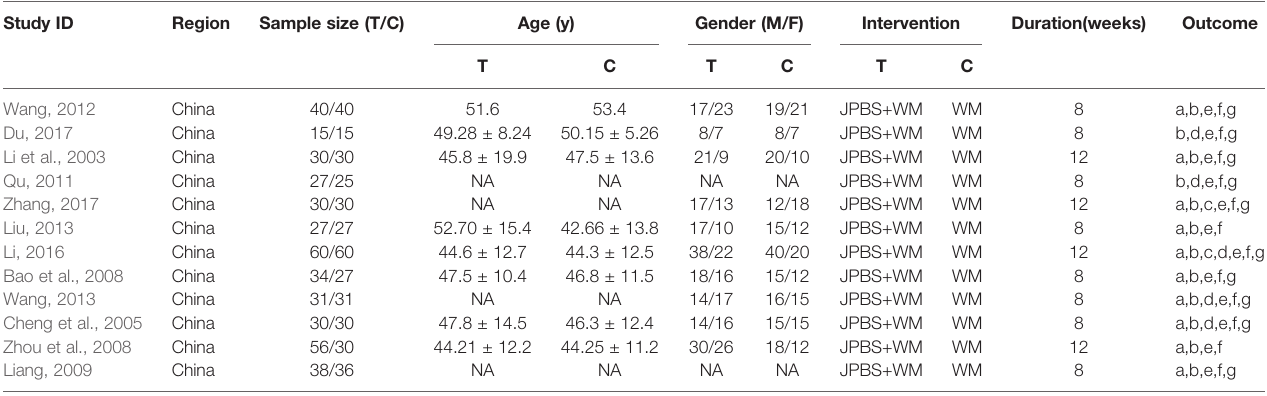
TABLE 1 | Characteristics of RCTs included in the study. Study